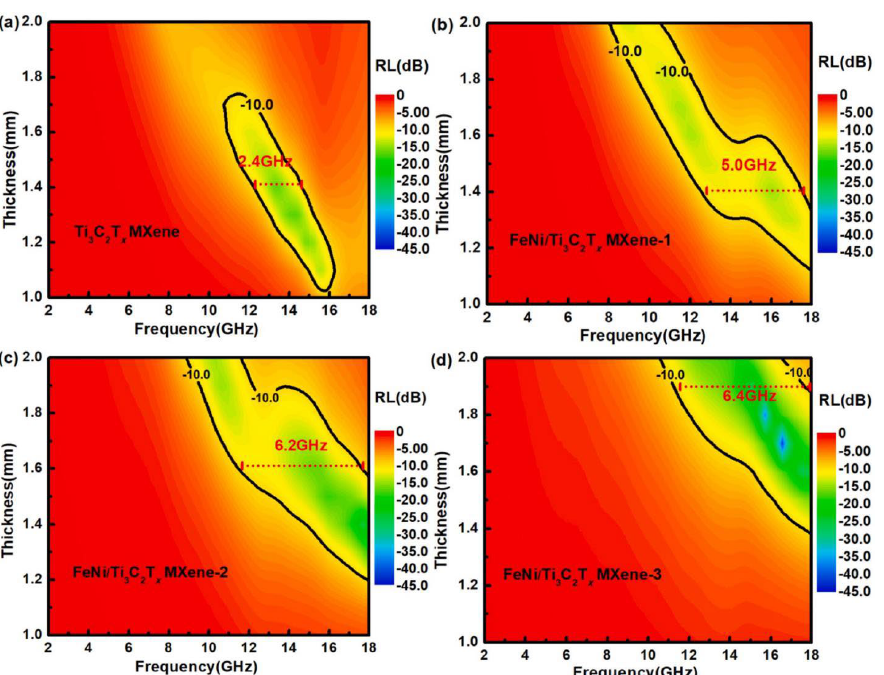
Figure 36. The color map of calculated RL values for the ( a ) Ti 3 C 2 T x MXene, ( b ) FeNi/Ti 3 C 2 T x MXene-1, ( c ) FeNi/Ti 3 C 2 T x MXene-2 and ( d ) FeNi/Ti 3 C 2 T x MXene-3 at thickness from 1.0 to 2.0 mm and over 2–18 GHz. For interpretation of the references to colour in this figure legend, the reader is referred to the web version of this article [76].